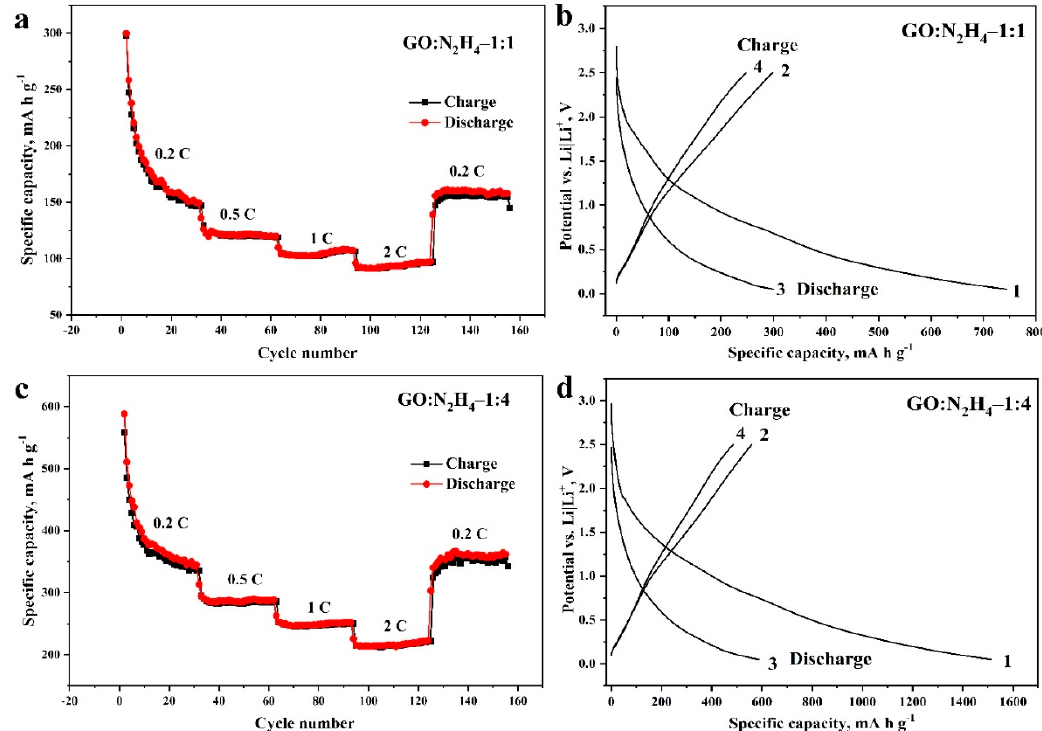
Figure 6. Dependence of specific capacity on the applied current and the number of charge and discharge cycles (from 2 to 160 cycles; ( a , c )) and dependence of potential on specific capacity during the first and second cycles of charging and discharging ( b , d ) of GO:N 2 H 4 –1:1 and GO:N 2 H 4 –1:4 active materials in Li batteries. The potentials are given relative to the Li|Li + electrode.